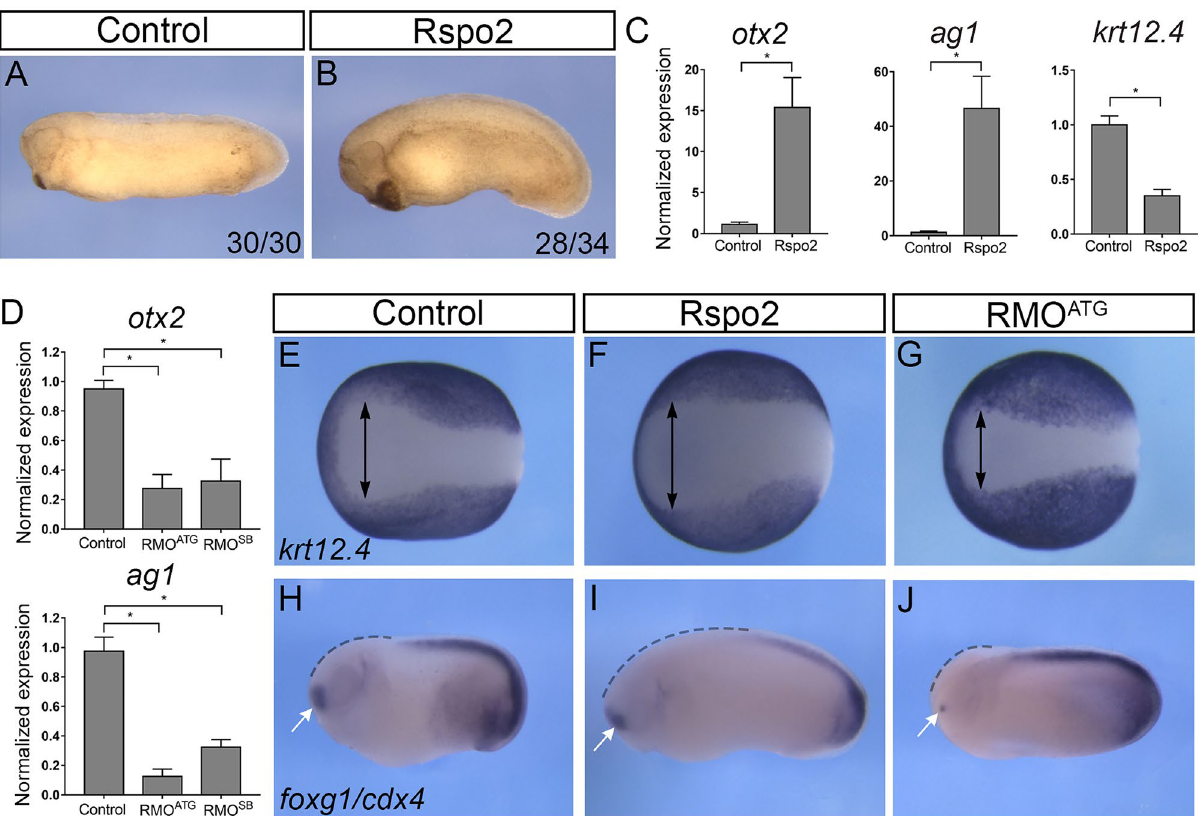
Figure 1. Rspo2 function is essential for anterior development. ( A , B ) Four-cell embryos were injected with 0.5 ng of Rspo2 RNA into both animal-ventral blastomeres and cultured until stage 28. ( A ) Uninjected control embryo. ( B ) Representative embryo injected with Rspo2 RNA. The penetrance is indicated as the ratio of the number of embryos with the phenotype and the total number of injected embryos. ( C ) The effect of Rspo2 on gene marker expression. Animal pole explants were dissected at stage 9 from embryos overexpressing Rspo2 RNA or uninjected controls. RT-qPCR analysis was carried out for otx2 , ag1 , and krt12.4 at stage 18. ( D ) Altered gene expression in Rspo2 morphants. RNA was isolated from stage 18 control embryos or embryos depleted of Rspo2. RT-qPCR for ag1 and otx2 was carried out in triplicates. ( C , D ) Each graph is a single experiment with triplicate samples, representative from at least 3 independent experiments. Means + /− s. d. are shown. Statistical significance has been assessed by Student’s t test, *, p < 0.05. ( E – J ) In situ hybridization of control and manipulated stage 16 or 25 embryos with krt12.4 ( E – G ), foxg1 and cdx4 ( H – J ) probes. ( E – G ) Width of the anterior neural plate is shown as lack of krt12.4 (arrows). ( H – J ) The foxg1 domain is indicated by white arrows, the anterior region lacking cdx4 —by dashed lines. See Supplementary Table 1 for